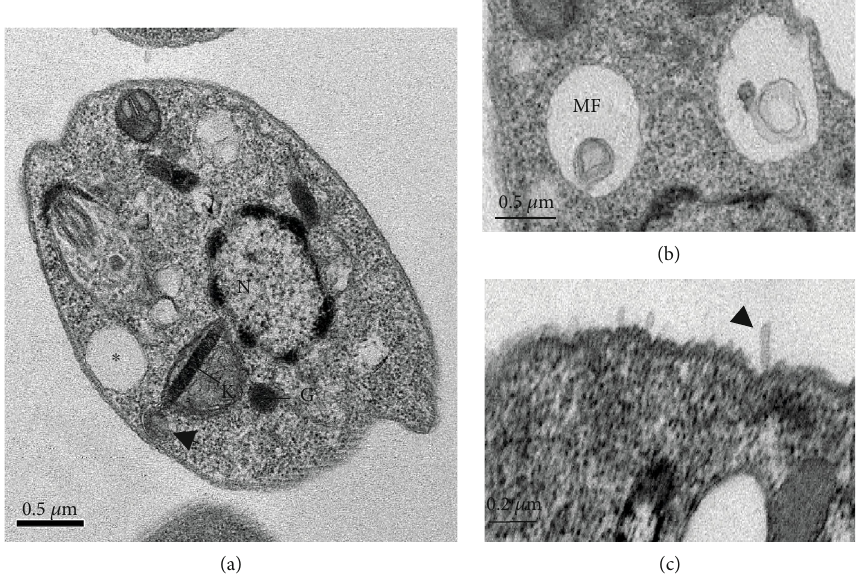
Figure 4: Ultrastructure of promastigote forms of L. ( L. ) infantum treated with IC of ursolic acid (UA) for 24h: (a) parasite showing round 50 shape morphology, with areas of cytoplasm degradation ( ∗ ) and nucleus with condensed and peripheral chromatin; the kinetoplast was swollen, and a bleb was identi fi ed (arrowhead) ( × 30K); (b) parasite treated with UA displayed myelin-like fi gures (MF) ( × 25K); (c) blebbing in the cell membrane (arrowhead) of promastigote forms treated with UA ( ×